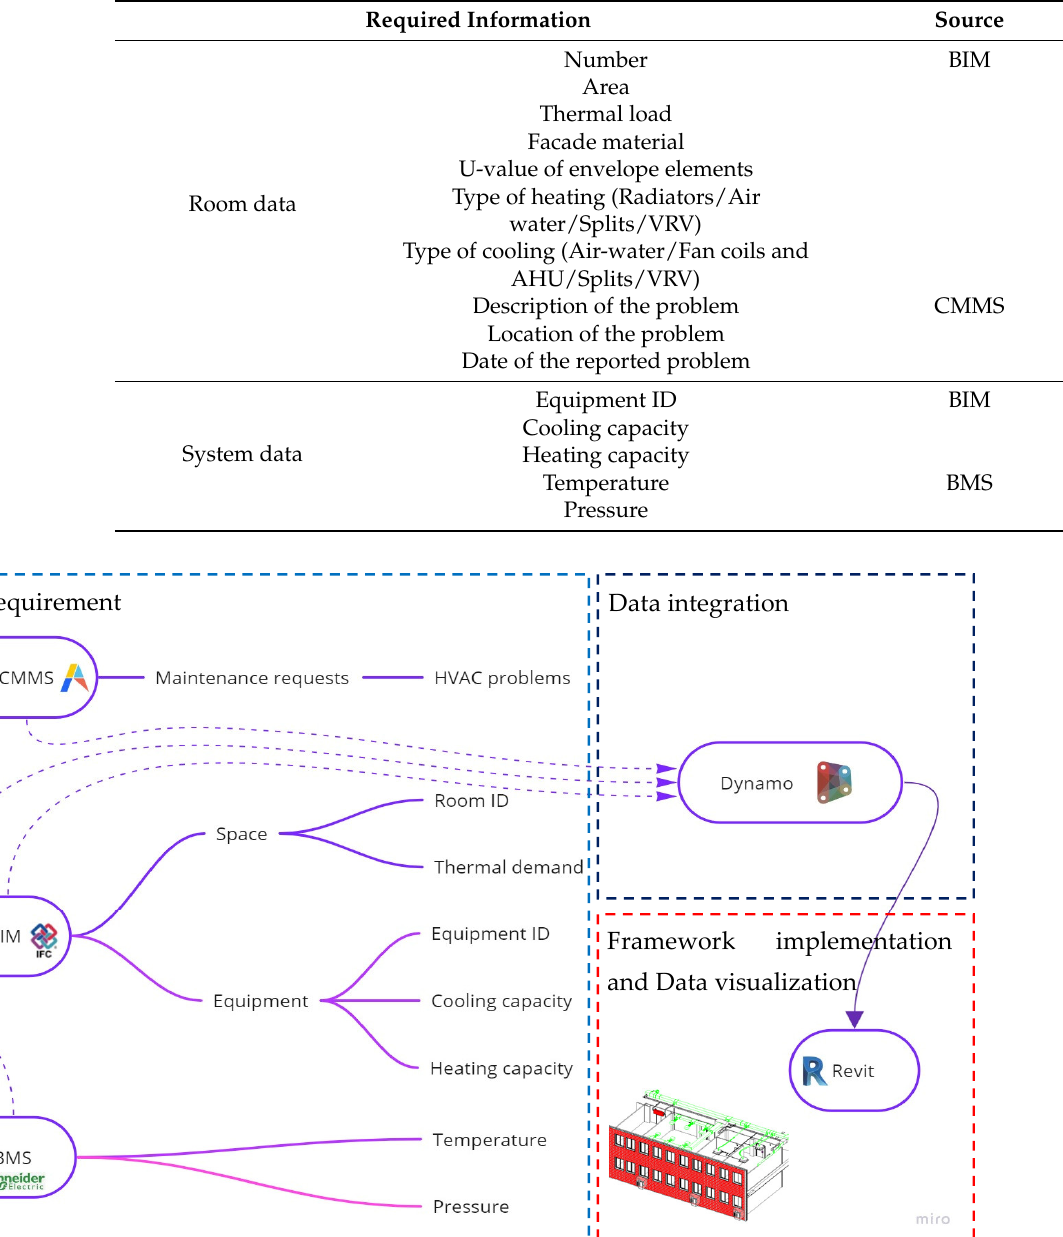
Table 1. Data requirement for the decision-making framework.